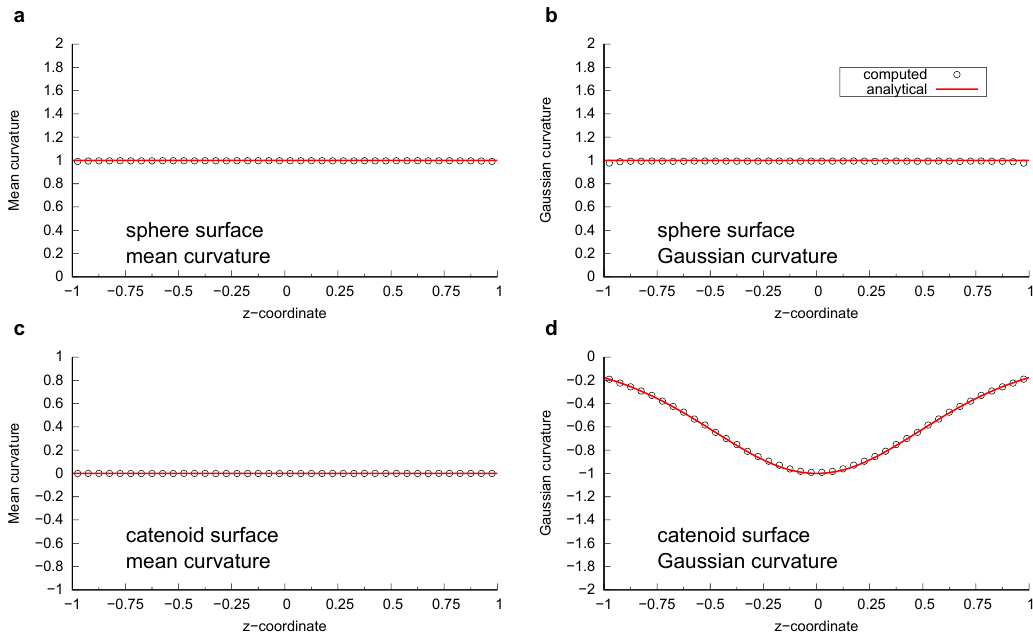
Figure 2. Comparison between computed and analytically obtained mean and Gaussian curvature as a function of z -coordinate. ( a ) Mean curvature of the sphere; ( b ) Gaussian curvature of the sphere; ( c ) Mean curvature of the catenoid; ( d ) Gaussian curvature of the